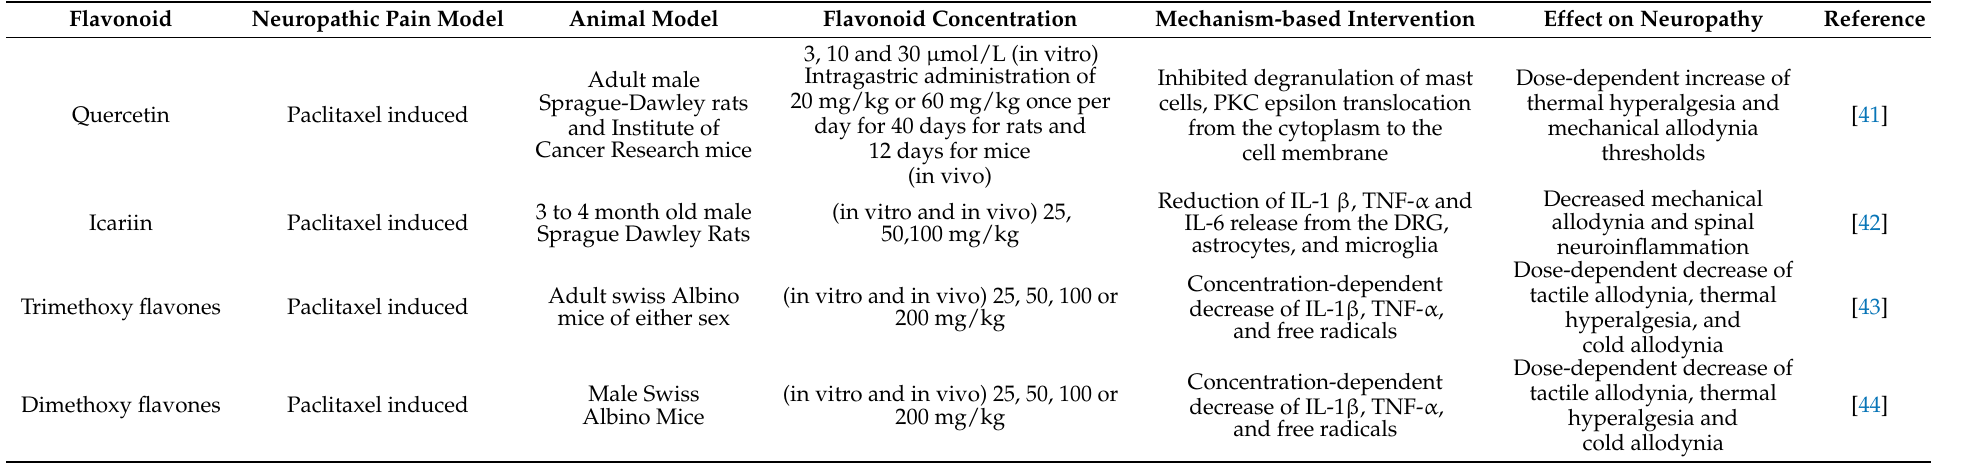
Table 2. Role of flavonoids in countering CIPN mechanisms at the peripheral